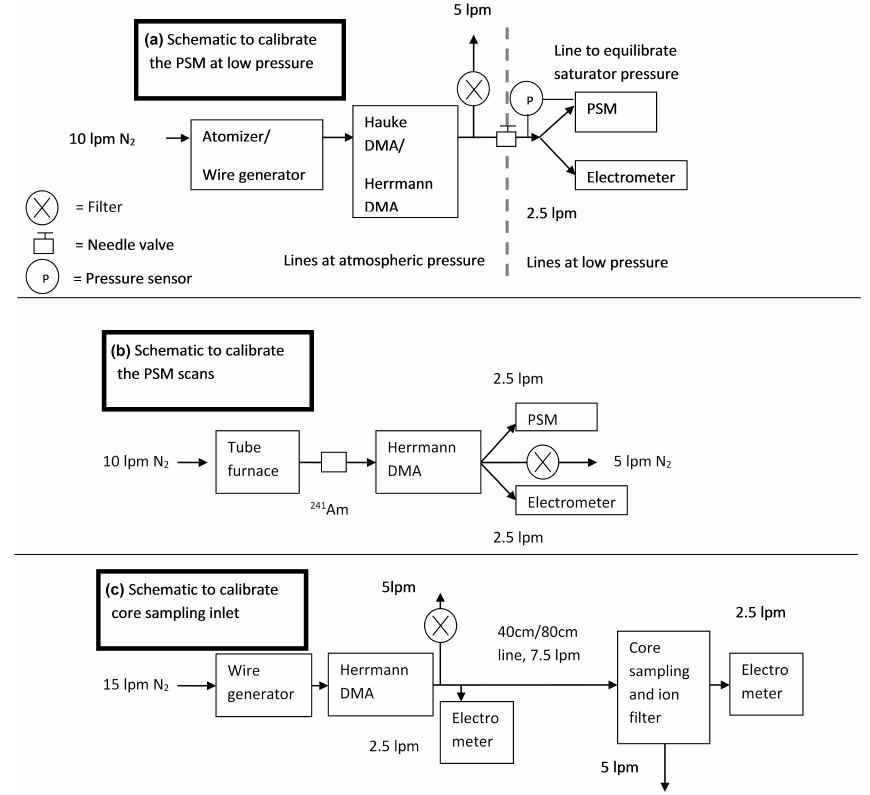
Figure 2. Schematic figures of the utilized experimental setups corresponding to different characterization experiments (a, b, c)